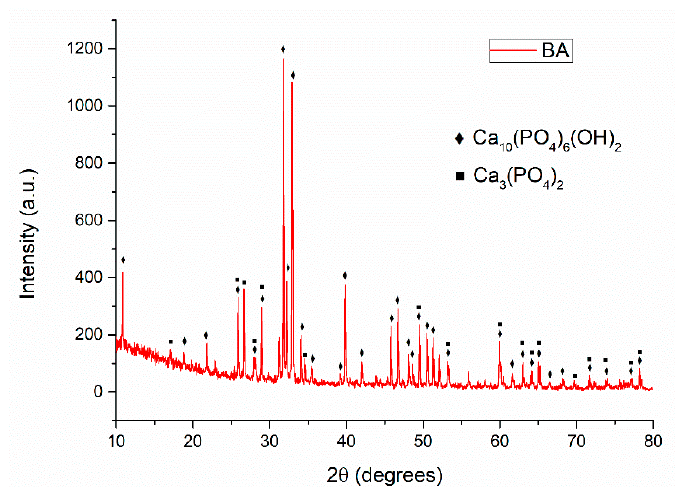
Polymers 2020 , 12 , x FOR PEER REVIEW Figure 4. XRD analysis of calcined bovine bone ash (BA) Figure 4. XRD analysis of calcined bovine bone ash (BA).